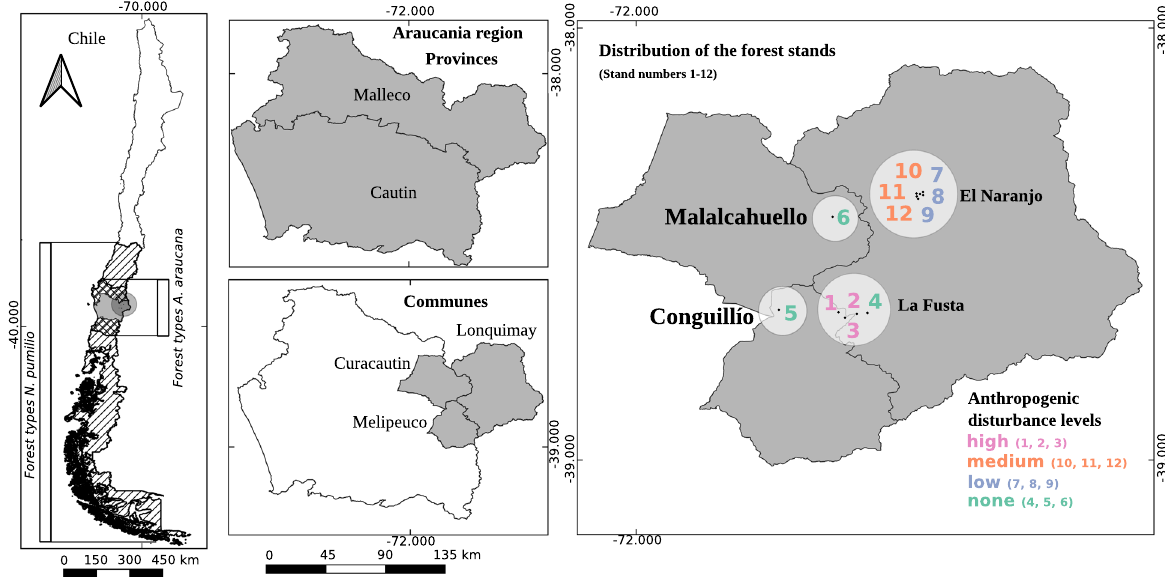
Fig. 1 Study area and distribution of 12 selected stands in the northeastern sector of the Araucanía region in southern Chile. Stands are located in La Fusta, Conguillío (National Park), Malalcahuello (National Reserve) and El Naranjo and are distinguished by four levels of anthropogenic disturbance: none, low, medium,